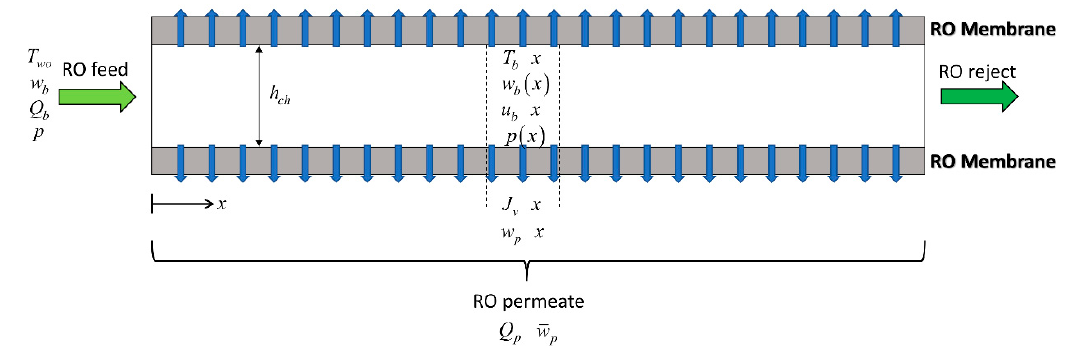
Figure 8. Schematic diagram of the unidimensional RO model, showing inputs, outputs and profile variables. Refer to the nomenclature for variable descriptions.